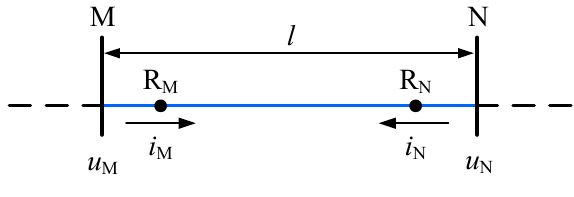
Figure 2. A uniform transmission line.